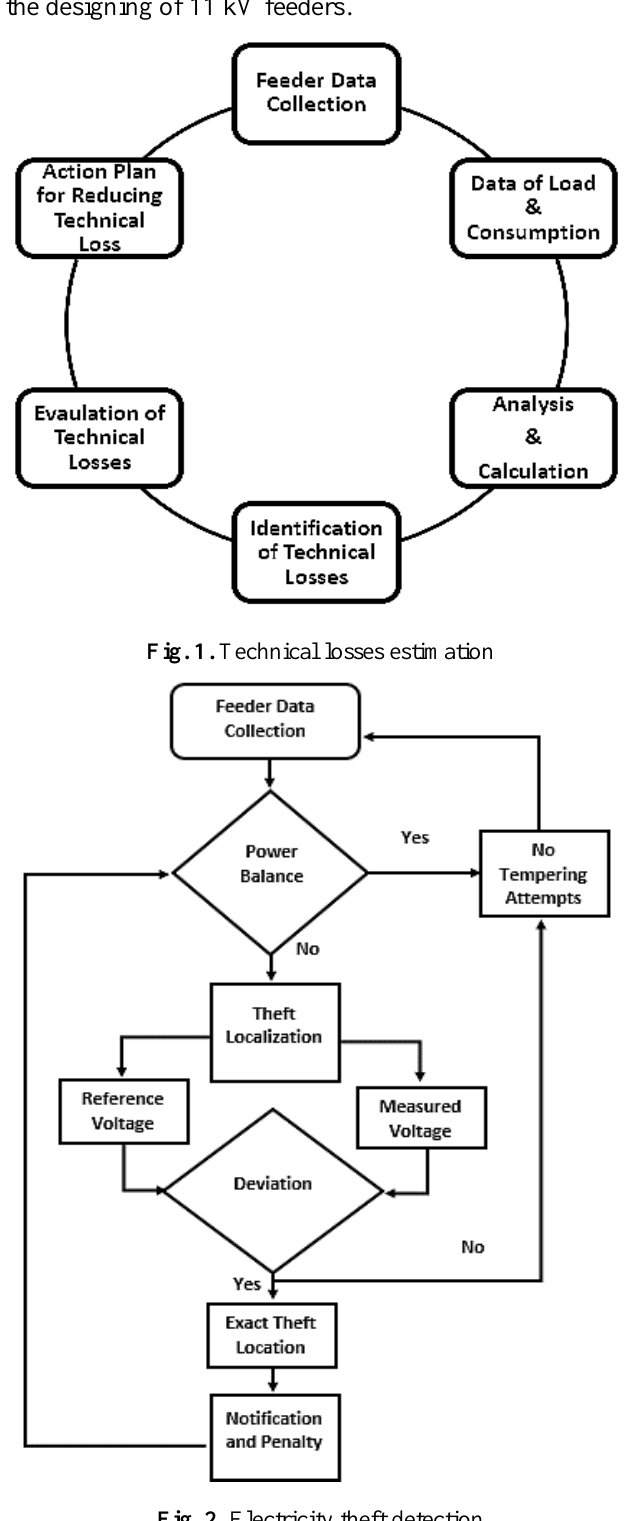
Fig. 2. Electricity theft